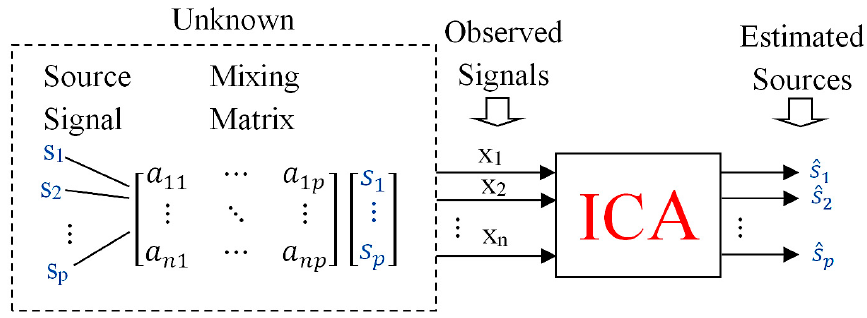
Figure 1. Schematic block scheme of Independent Component Analysis.